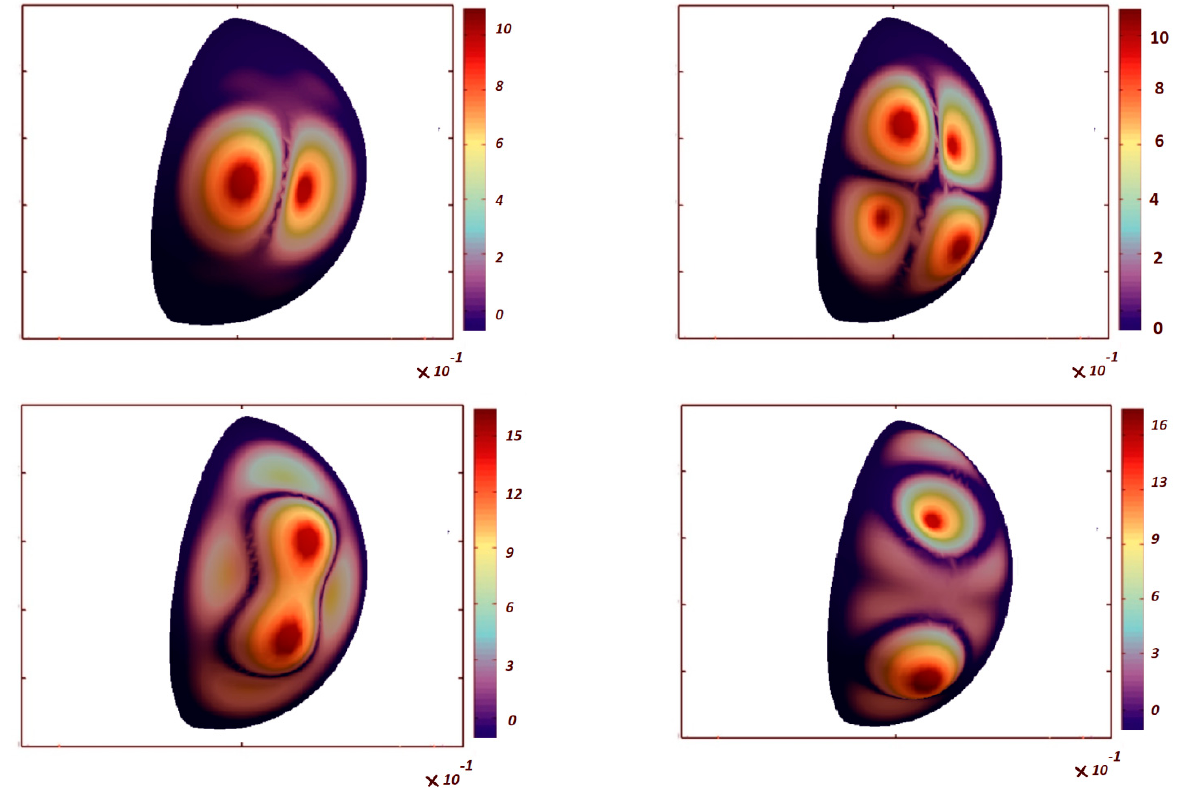
Figure 4. The first six buckling mode shapes of FG-GPL, porous spherical cap ( ϑ = 180 ◦ , φ = 90 ◦ , GPL-X, PD1, e 0 = 0.4, γ = 0.01